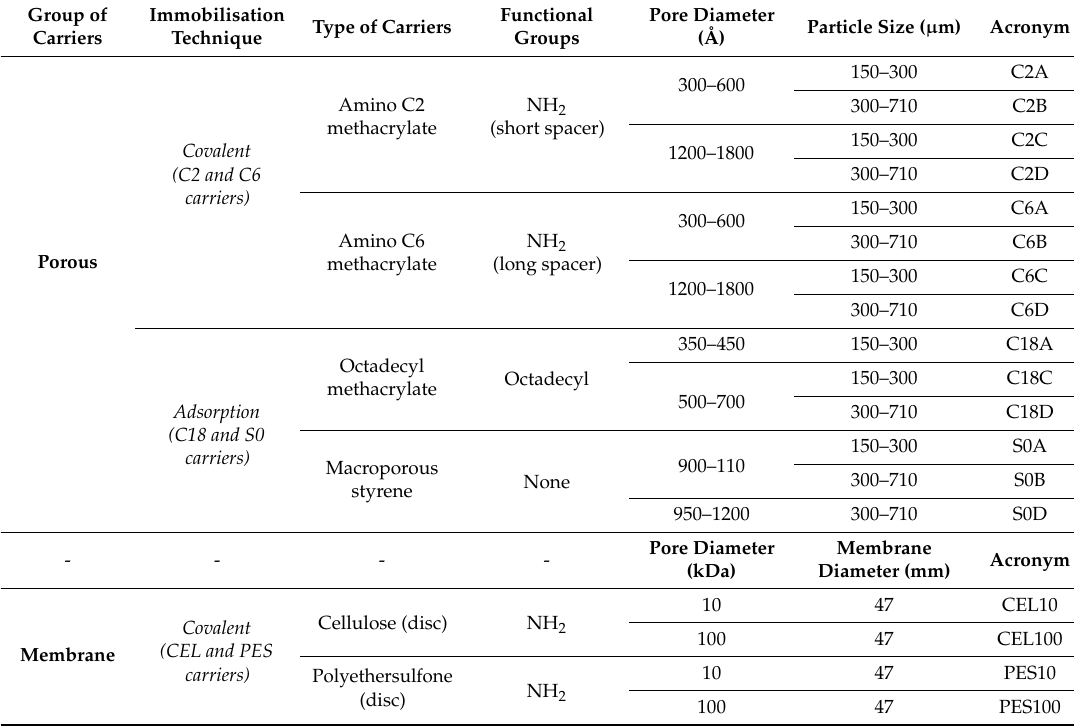
Table 7. Characteristics and acronyms of tested